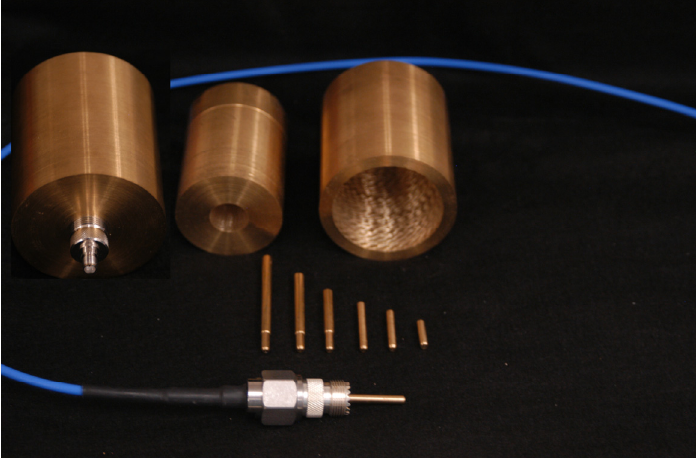
Figure 6. Machined brass coaxial cell based on commercial N to UHF (RF)